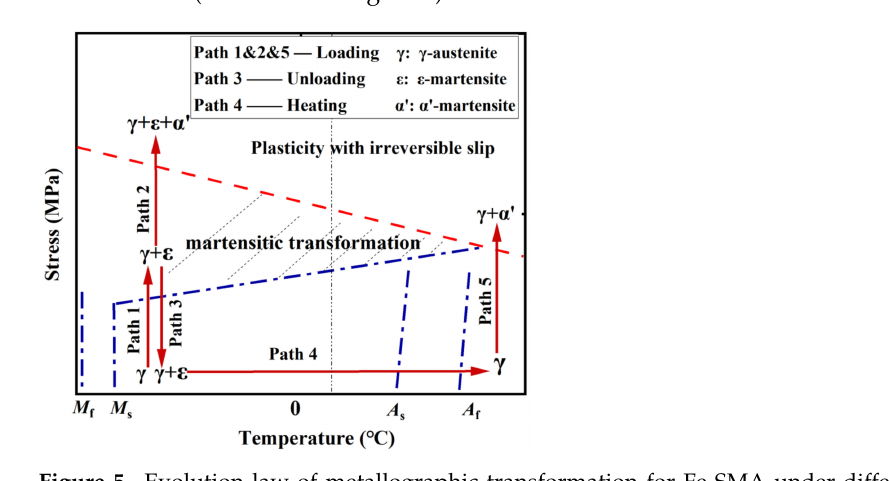
Figure 5. Evolution law of metallographic transformation for Fe-SMA under different thermal- mechanical